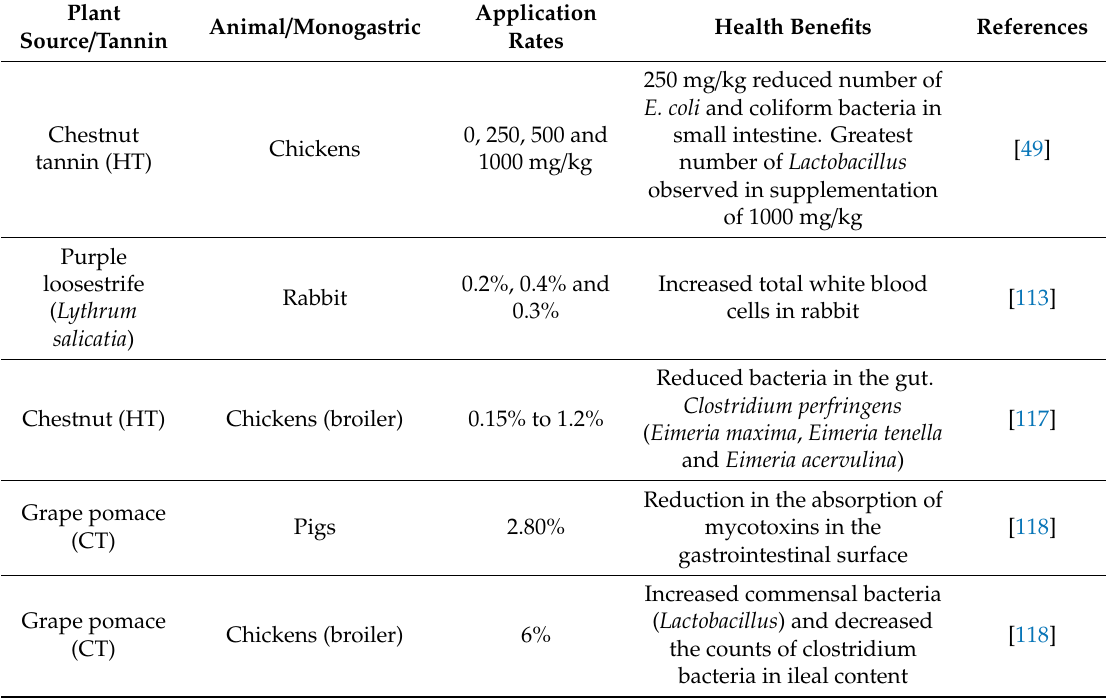
Table 6. Health benefits of tannins in monogastric